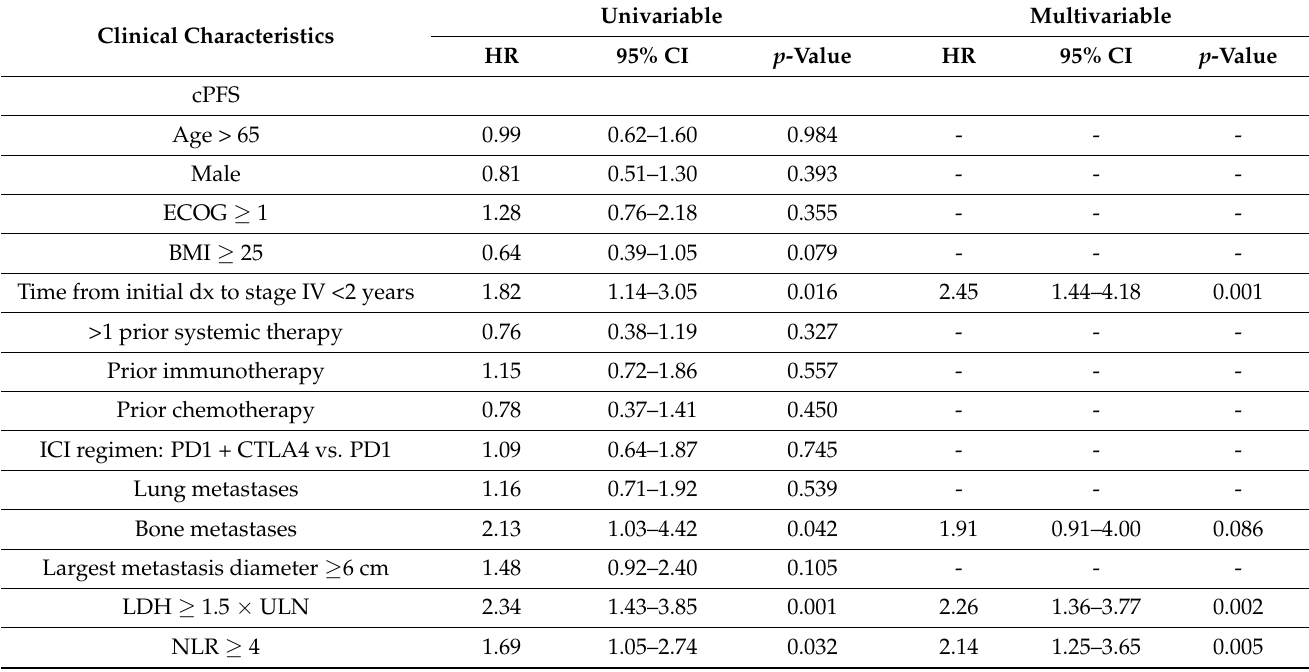
Table 2. Clinical variables associated with clinical progression-free survival ( n = 75).